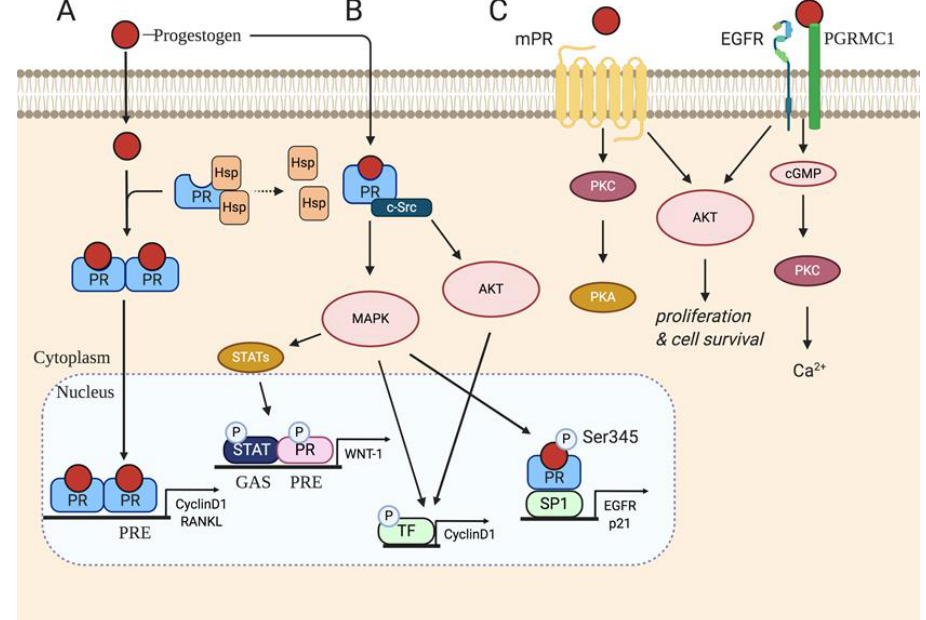
Figure 1. Overview of progesterone actions via classical and non-classical signaling. ( A ) Progestogen induced classical signaling to PRs leads to heat shock protein (HSP) dissociation, PR dimerization, progesterone response element (PRE)-binding and transcription of downstream e ff ector targets, Cyclin D1 and RANKL. ( B ) Rapid progestogen non-classical activation of membrane-proximal actions on proto-oncogene tyrosine-protein Src (c-Src), mitogen activated protein kinase (MAPK) and protein kinase B (AKT) promotes PR phosphorylation and tethering to transcription factors that can then transcribe WNT-1, Cyclin D1, EGFR and p21. ( C ) Progestogens initiate non-classical signaling of membrane progesterone receptors (mPRs) and progesterone receptor membrane component 1 (PGRMC1) by activating downstream targets, protein kinase c (PKC), protein kinase a (PKA), cyclic guanosine monophosphate (cGMP) and AKT leading to Ca 2+ influx, proliferation and cell survival. Figure 1 was created using Biorender.